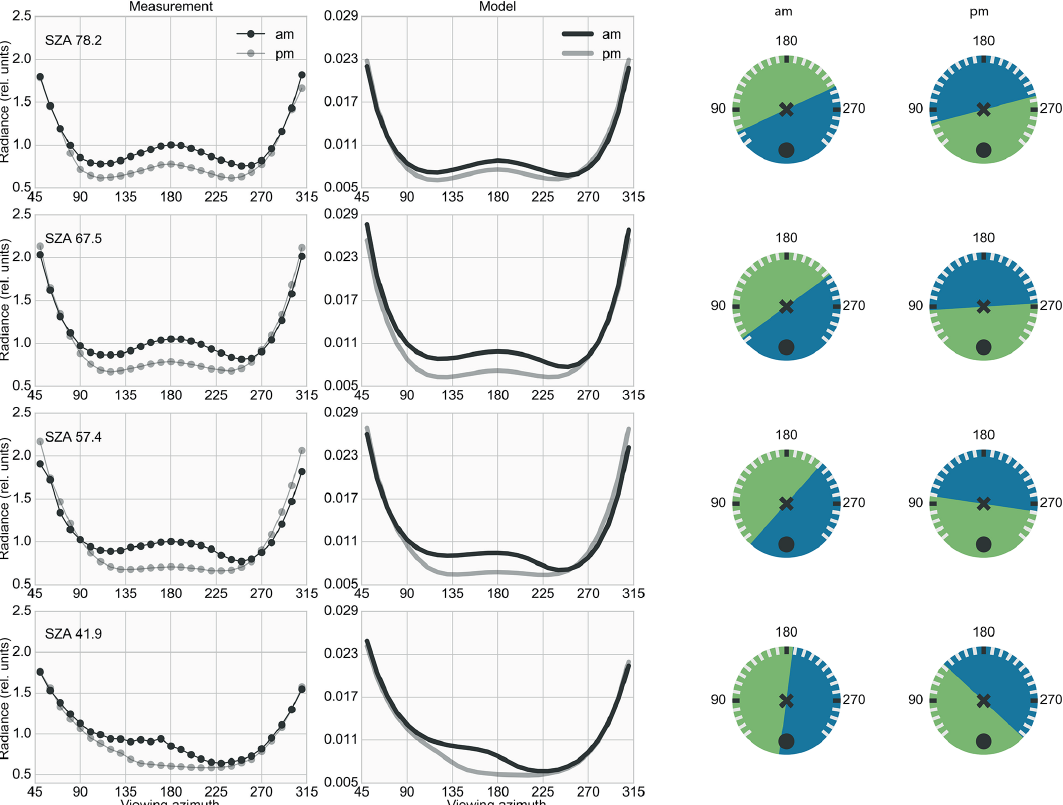
Figure 2. Measured and modelled radiances at 850nm at 70 ◦ viewing zenith angle at the coastal site at four SZAs in the morning (am) and afternoon (pm). Units are relative units (counts for measurements, transmittance for model simulation) but are irrelevant for the analysis here. The right panel shows the solar azimuths (dark circles) and the viewing azimuth angles (white dashes) in relation to the coastline (land is green; ocean is blue). Note how the radiance is higher for viewing directions towards the land, as compared to the